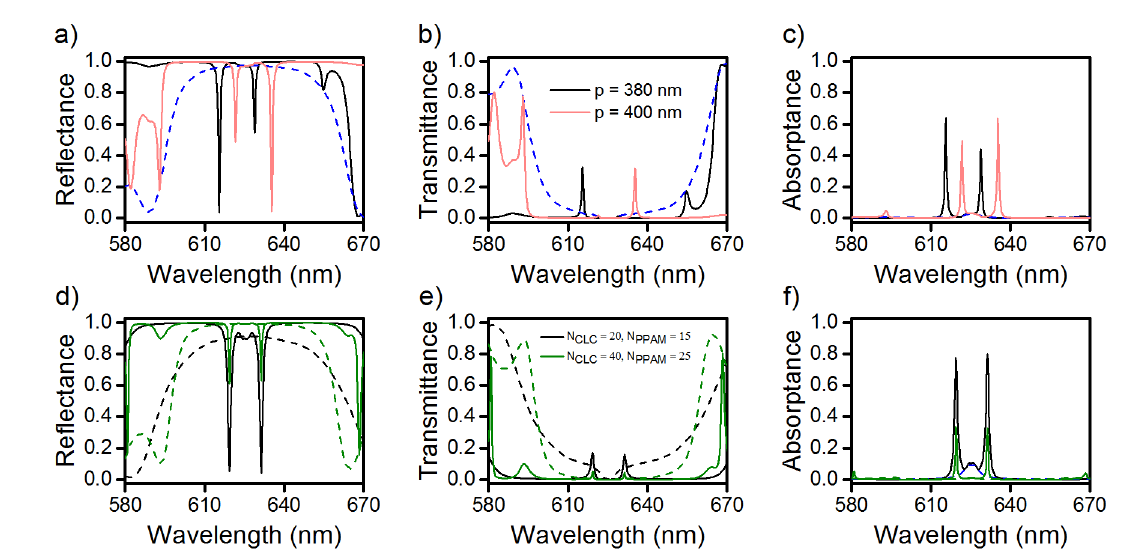
Figure 4. ( a , d ) Reflectance, ( b , e ) transmittance, and ( c , f ) absorptance spectra of the investigated structure at different cholesteric helix pitches and PPAM and CLC geometric parameters. Solid lines correspond to the diffracting polarization and the dashed lines, to the nondiffracting one. The rest parameters are the same as in Figure 2.